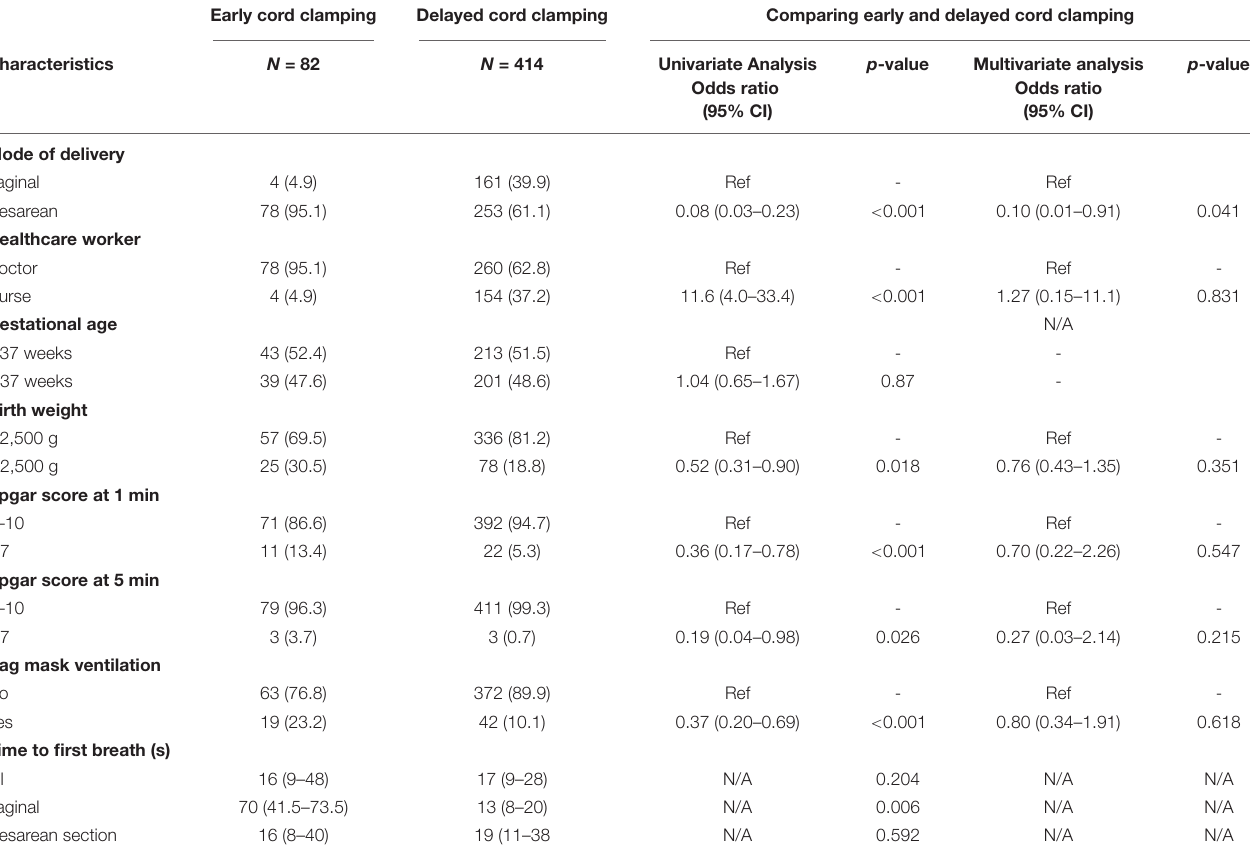
TABLE 4 | Comparing characteristics of deliveries with early ( < 30 s) vs. delayed ( ≥ 30 s) cord clamping. Early cord clamping Delayed cord